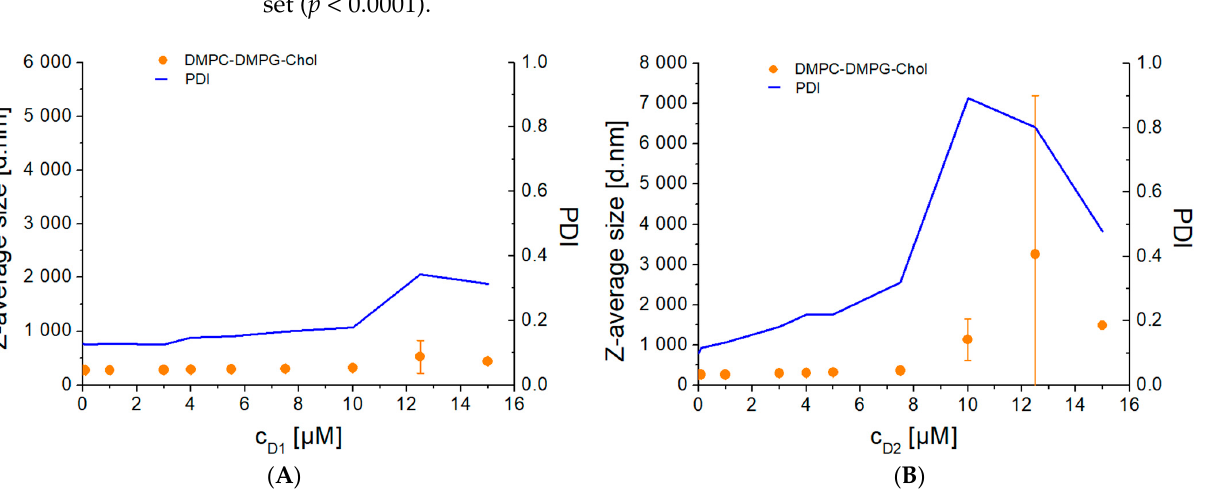
Figure A2. The hydrodynamic diameter (Z-average; (d.nm + SD)) and polydispersity index (PDI) of negatively charged DMPG − DMPC − Chol liposomes upon the increasing concentration of D1 ( A ) and D2 ( B ) dendrons in Na-phosphate buffer (10 mM, pH 7.4) at 37 °C.